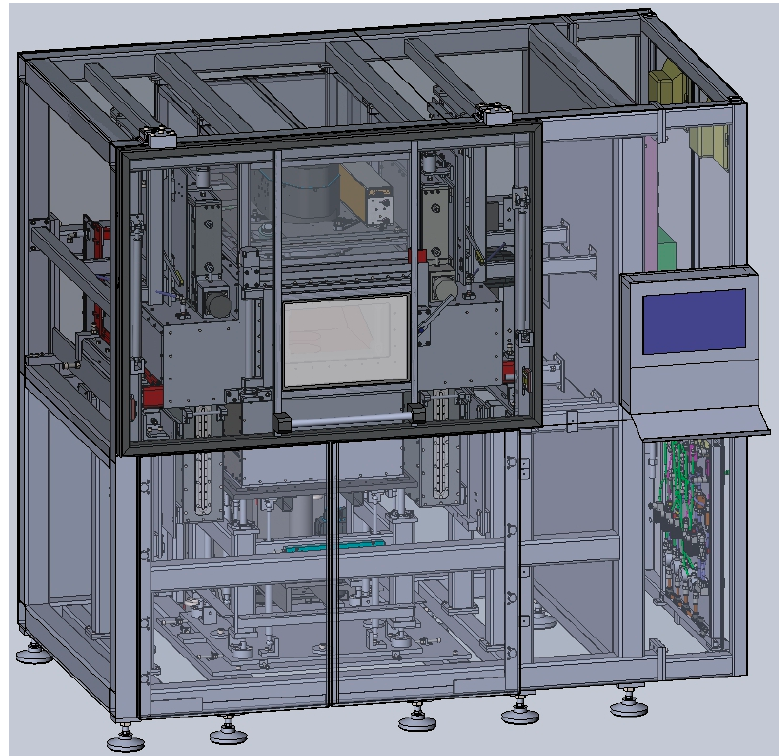
Figure 2. General view of the SLS machine (the outer panels are conditionally shown as transparent). Dimensions 2470 × 1570 × 2480 mm (length × width × height).